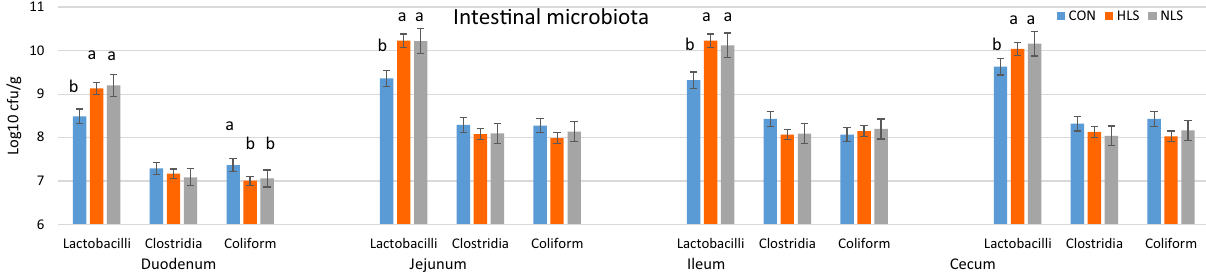
Figure 7. The population of lactobacilli, clostridia, and coliform at different sections of the intestine at the end of study (d21, weaning). CON, Control without probiotic; HLS, L. salivarius 144 isolated from fast-growing pig feces; NLS, L. salivarius 160 isolated from normal weight pig feces.